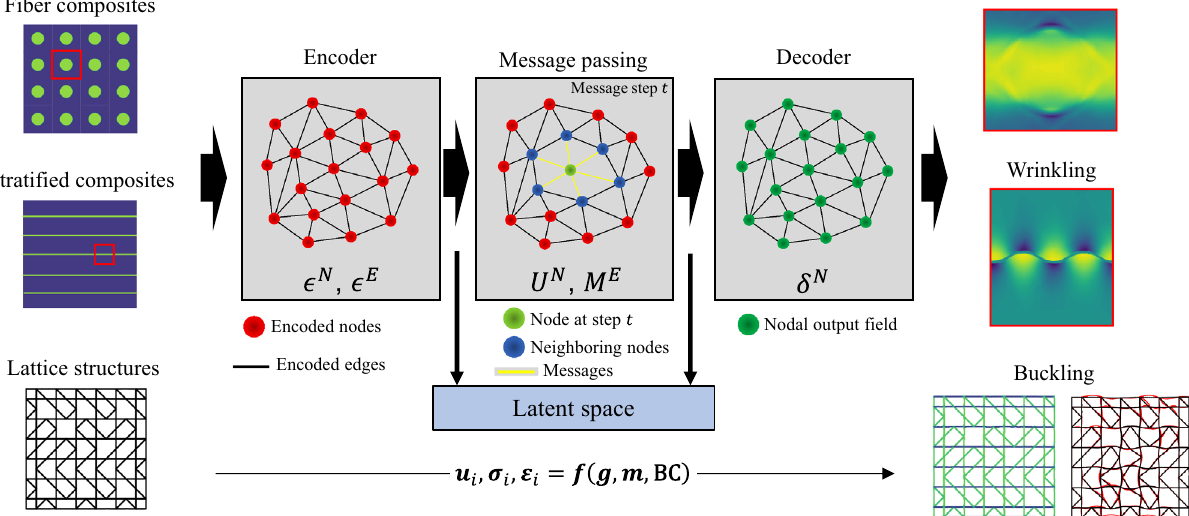
Figure 1. Schematics of the proposed ML model. The meshed material or structural system is first mapped onto a graph. Three examples of various complexity are here shown. Node and edge features are defined over the graph structure, carrying information of the system, such as node positions, node type (i.e., base material phase), or displacements on specific nodes. These features are first encoded into a larger latent space. Then, a message-passing module processes the graph features: each node acquires information from its neighboring nodes, learning relationships between different parts of the system. The transformed nodal quantities are finally decoded into output physical fields, here, deformation, stress, and strain fields ( u i , σ i , ε i ). Providing geometric/ topological information ( g ), base materials’ behavior ( m ), and boundary conditions ( BC ), the model learns physical relationships with the considered fields. Once trained, the ML model can accurately predict physical fields of various material and structural systems subject to complex physical phenomena, such as wrinkling or